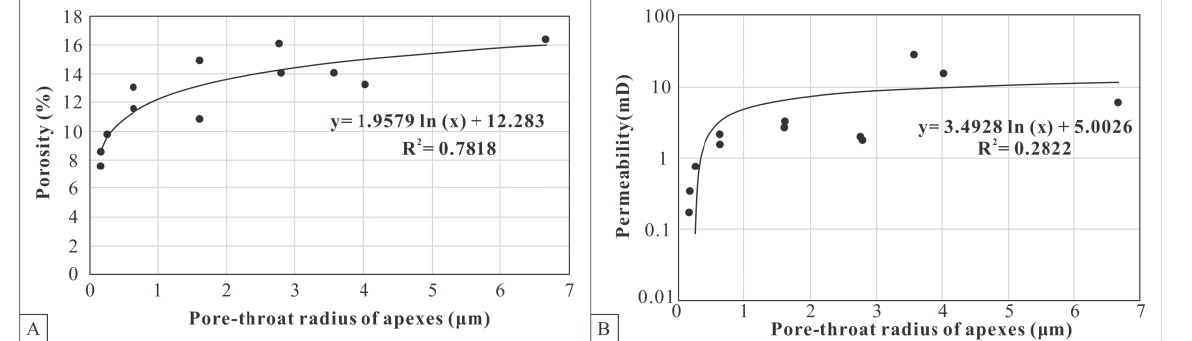
Figure 8. Correlation between the parameter of apexes and physical properties. ( A ) Correlation between pore-throat radius and porosity at the turning point (apex). ( B ) Correlation between pore throat-radius and permeability at the turning point (apex).